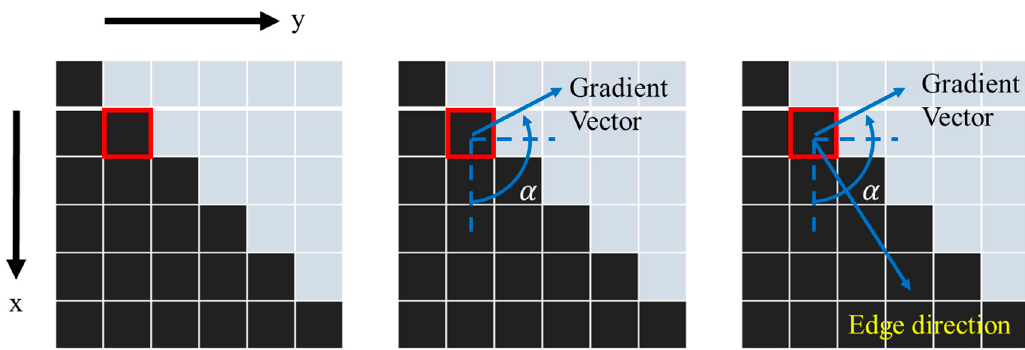
Figure 9. Edge direction and intensity of a point determined by the gradient.